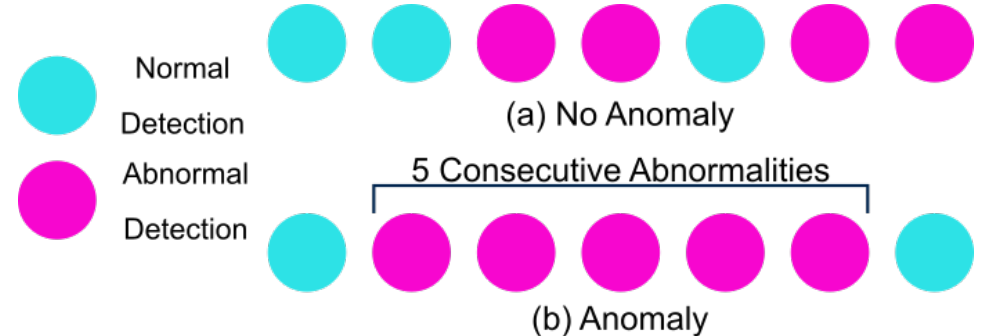
Figure 3. An example of what is considered an anomaly for this